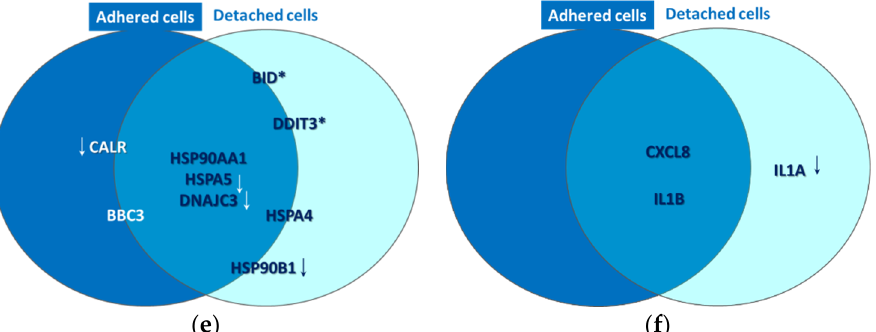
Figure 10. Common and distinctive gene expression patterns in adhered and attached HT29 tumor cells that were exposed to P2.2-PDT (10 J/cm 2 , 50 mW/cm 2 ) at 24 h post-PDT. Some selected genes with modified expression in PDT-treated cells as compared to untreated cells (1.5 < FR < −1.5, p < 0.05) are represented. These genes are involved in ( a ) oxidative stress, ( b ) Hypoxia signaling, ( c ) cell death, ( d ) DNA damage, ( e ) unfolded protein response and ( f ) inflammation. All the reported genes were upregulated, excepting those marked with downwards arrows. Genes placed at the borders of the two circles are expressed both in adhered and detached cells, but have higher expression in one of the two cell types. This comparison between gene expression levels in adhered and detached cells was performed with a paired samples t -test (* p < 0.05, ** p < 0.01, *** p < 0.001).